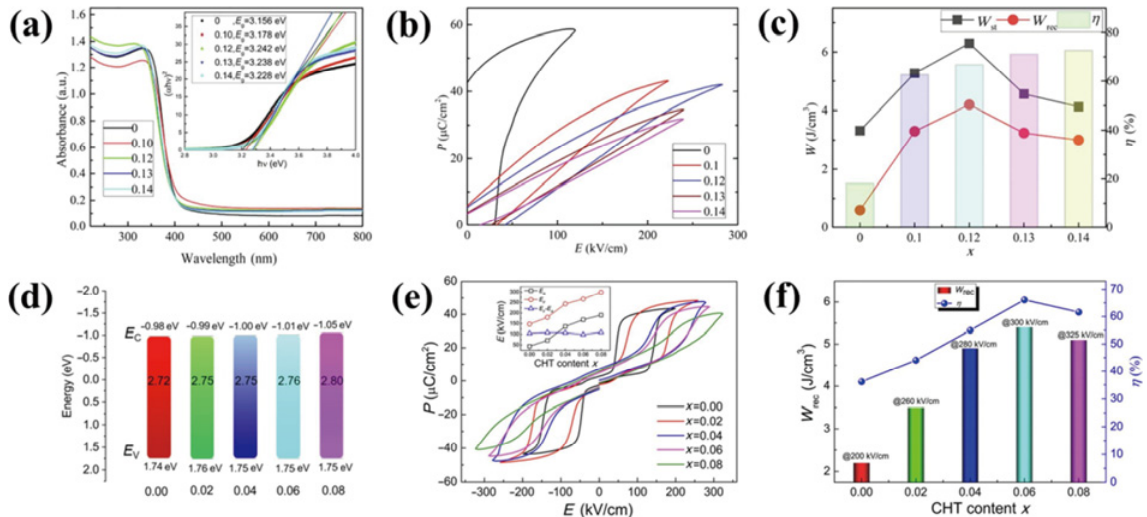
Fig. 11 (a) Ultraviolet–visible absorbance spectra and optical E g of BNBT–CH ceramics. (b) P – E loops and (c) energy storage performance of BNBT–CH ceramics. (d) Schematic diagram of energy band structures of AN–CHT ceramics, where E C and E V are the energy of the CB and VB, respectively. (e) P – E loops and (f) energy storage performance of AN–CHT x ceramics. Reproduced with permission from Ref. [62] for (a–c), © Elsevier B.V. 2021; Ref. [61] for (d–f), © Elsevier B.V.